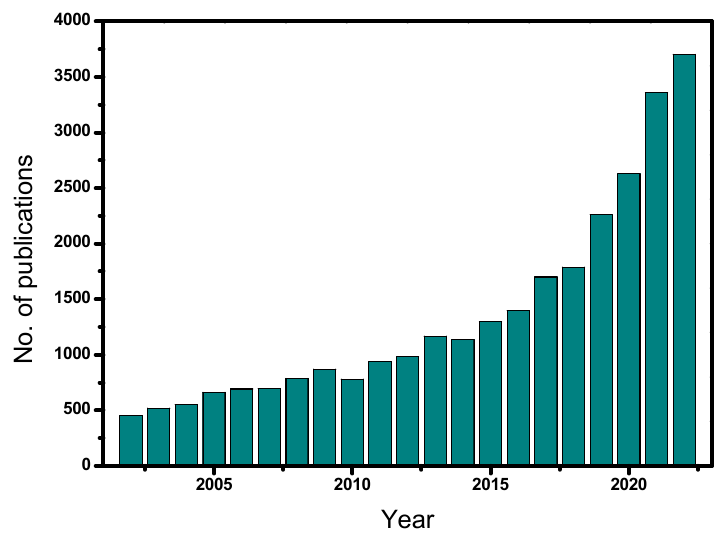
Figure 1. Published scientific studies on heterogeneous catalytic ozonation for the period 2002–2022.